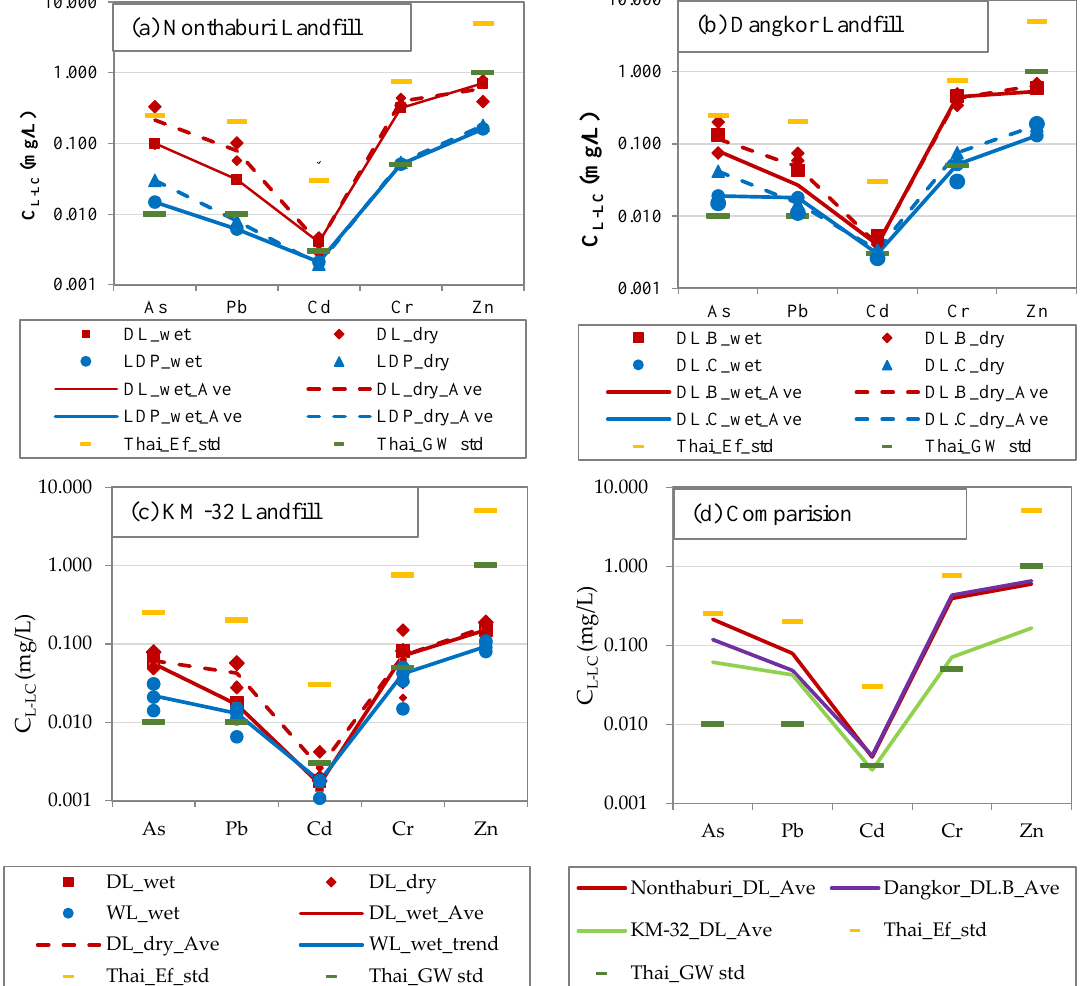
Figure 7. Heavy metal concentration of the liquid part of the leachate samples (C L-LC ): ( a ) Nonthaburi landfill; ( b ) Dangkor Landfill; ( c ) KM-32 landfill; and ( d ) Average heavy metal concentration in the liquid part of the leachate (C L-LC ).